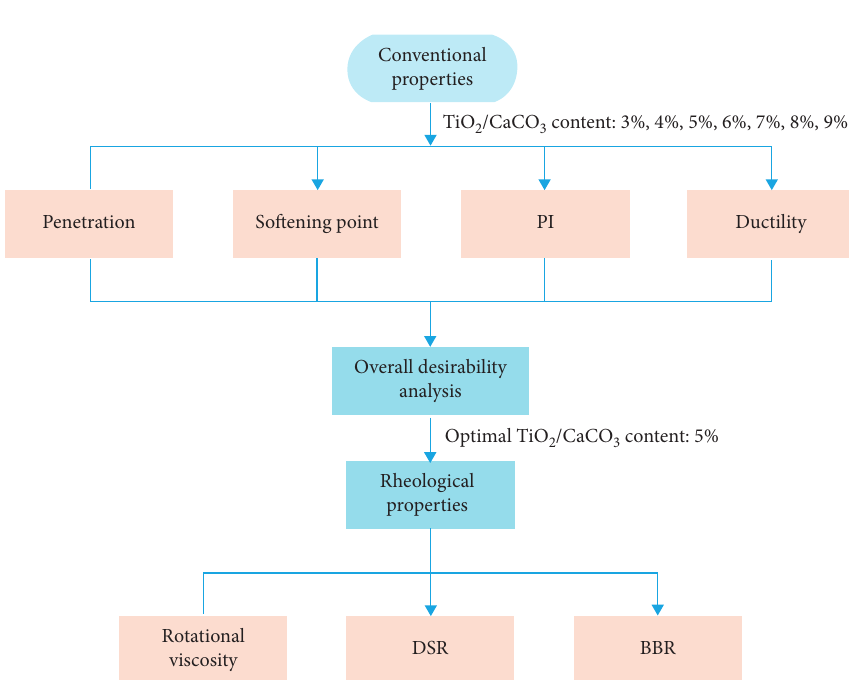
Figure 2: Bituminous sample preparation procedure in this study.